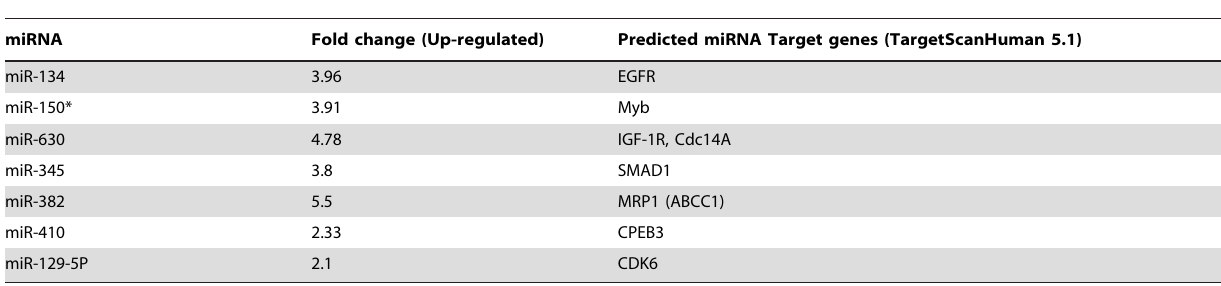
Table 1. 3-Cl-AHPC mediated modulation of microRNAs and target genes in PANC-1 cells.